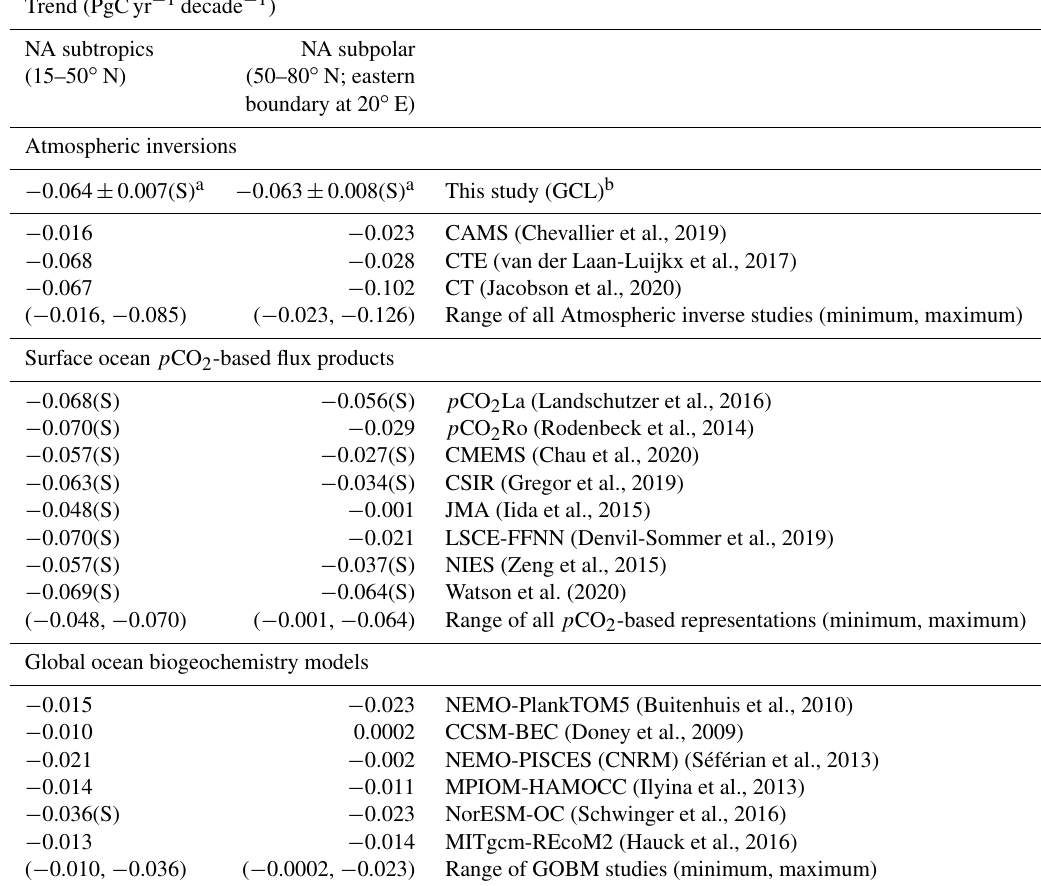
Table 4. Summary metrics of GEOS-Chem–LETKF North Atlantic (NA) CO 2 flux estimates and comparison with independent estimates (from atmospheric inverse analyses, surface p CO 2 mappings, and global ocean biogeochemistry models (GOBMs)) for the period 2000– 2017. Listed are estimates for the trend of the regional fluxes over the period. The metrics listed in this table are plotted in Fig. 3e and f of the main study.